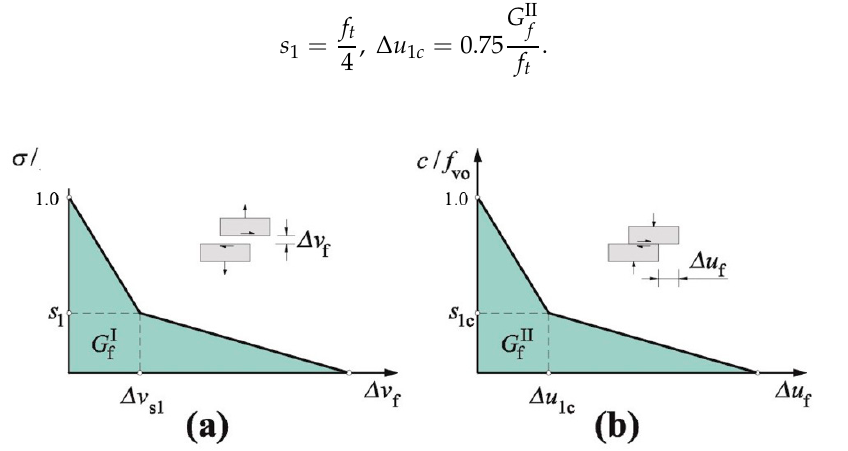
Figure 13. Simplified softening laws ( a ) for normal tensile stresses, ( b ) for cohesion (initial shearing strength).